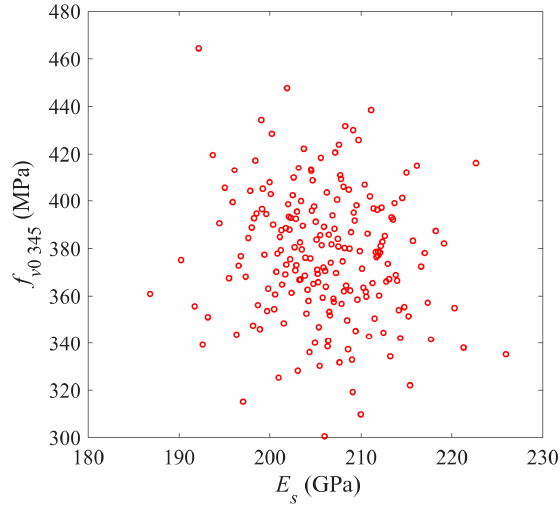
Figure 3. Sample point.